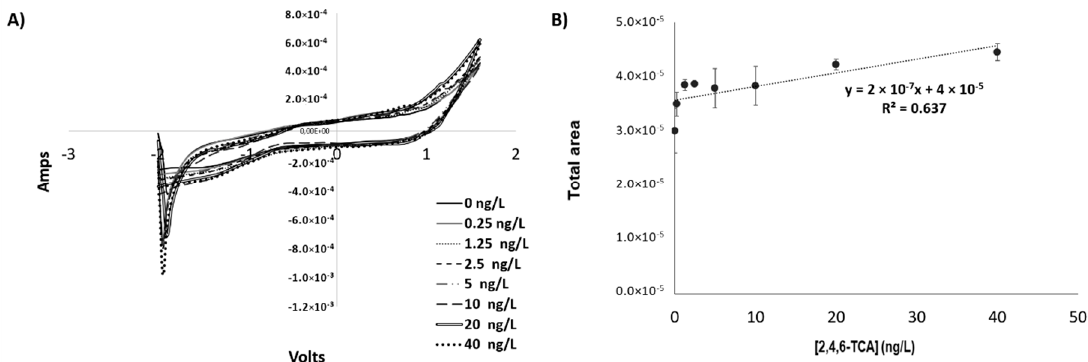
Figure 8. Cyclic voltammograms for MeOH/H 2 O mixtures (3:2 ( v / v ) with 0.1 M of TBAP) without (0 pg/mL, black line) and with 2,4,6-TCA addition (0.25 to 40 ng/L) ( A ); Schematic representation of the calibration curve obtained for different 2,4,6-TCA concentrations in MeOH/H 2 O mixtures (3:2 ( v / v ) with 0.1 M of TBAP) ( B